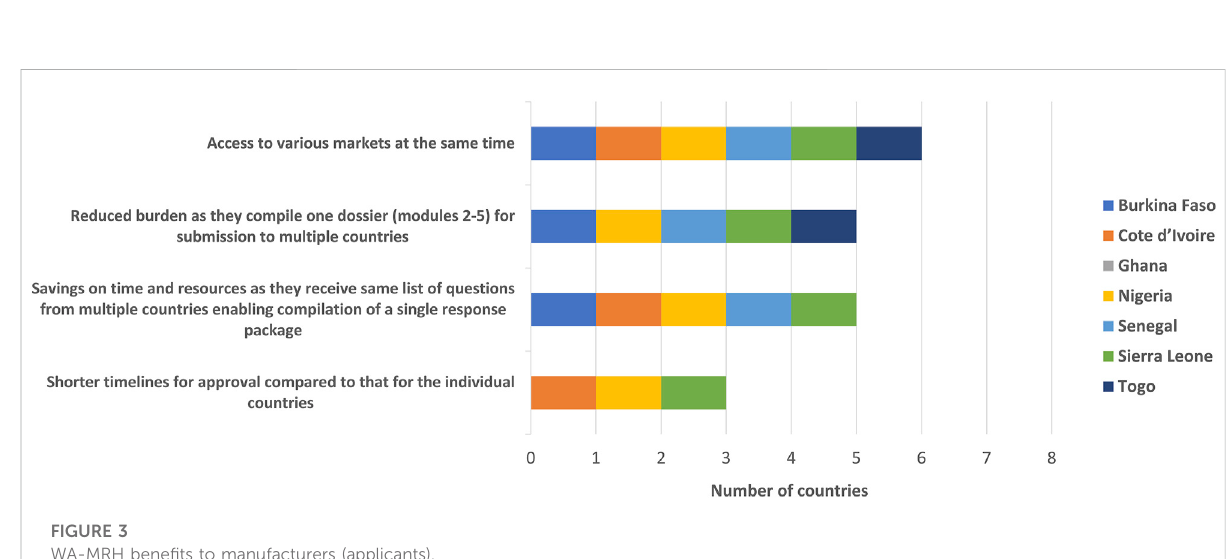
FIGURE 2 WA-MRH bene fi ts to member countries (regulators).